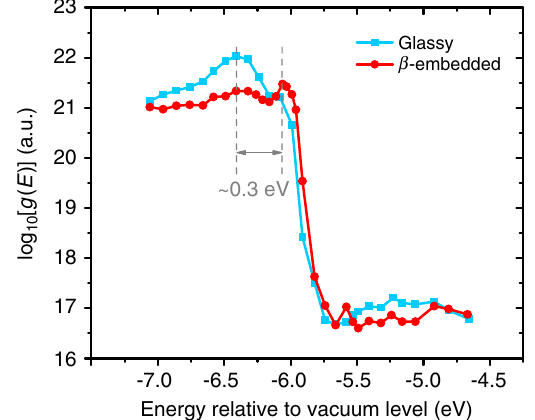
FIG. 6. Density-of-states curves of the HOMO branch mea- sured by ER-EIS for thin films ( ∼ 40 nm) of glassy (blue) and β -phase embedded (red) PFO. The β -phase embedded sample shows a distinct satellite peak around 0.3 eV above the HOMO peak of the glassy sample. The faint shoulder visible in the glassy sample around the position of the β -phase feature is likely due to contamination with a minute amount of β -phase developed during preparation of the glassy